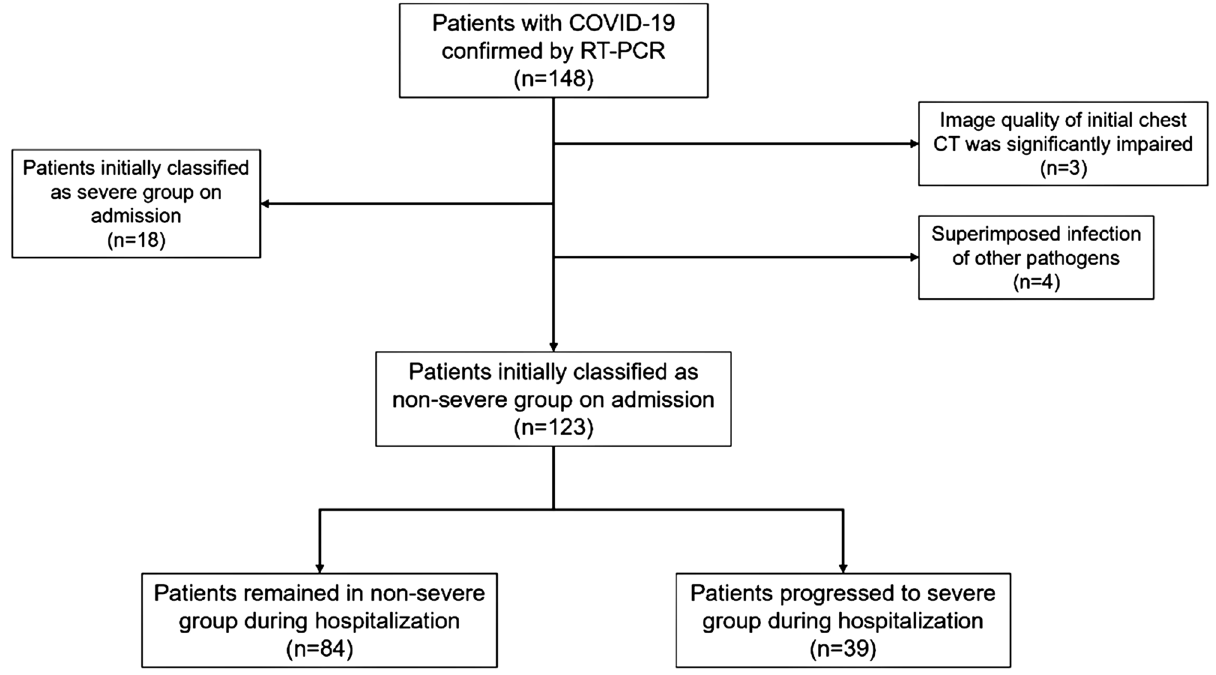
Figure 1. Flow chart of inclusion and exclusion. COVID-19 Coronavirus disease 2019, CT computed tomography, RT-PCR reverse transcription polymerase chain